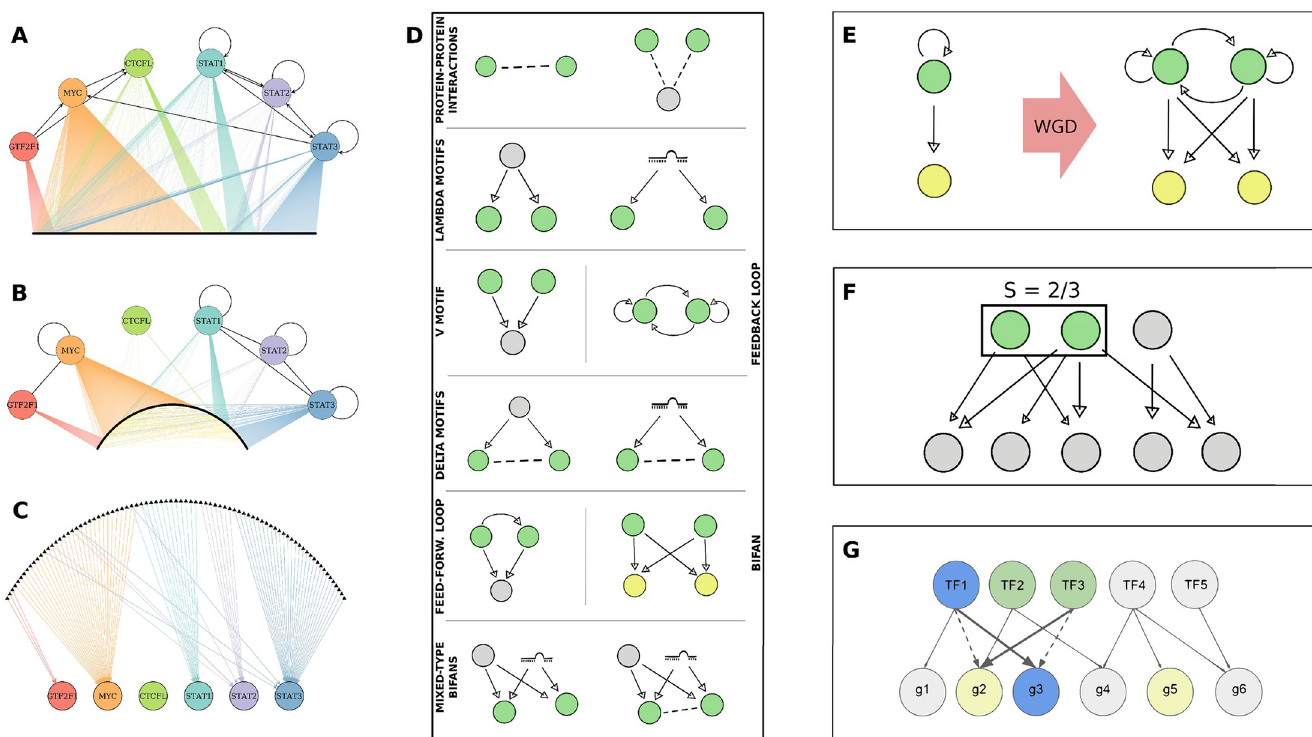
Fig 1. Regulatory networks and network motifs. Interactions involving an illustrative subset of TFs are shown on the left for each of the regulatory mechanisms studied in the present work, i.e. for (A) transcriptional regulations from the ENCODE network, (B) protein-protein interactions in the PrePPI network, and (C) miRNA-gene regulatory interactions in the TarBase network. TFs are represented as colored circles, target genes as small black dots (here appearing as a thick black lines due to large number of genes), and miRNAs as black triangles. Black lines indicate interactions between TFs, while other interactions have the color of the involved TF. Yellow lines are interactions between non-TFs. (D) An overview of the network motifs that will be considered in the following. Gray circles represent generic genes, same-color circles (green or yellow) are paralogues, and miRNAs are represented in a stylized form. Solid arrows represent regulatory interactions, while dashed lines represent protein-protein interactions. (E) Illustration of how a WGD event can easily create FFLs and Bifans by duplicating the components of a simple regulatory interaction in which the regulator also has self-regulation. Many of the created interactions will then be lost during the evolutionary process, leaving only those that are not negatively selected. (F) Example of the structure of a Dense Overlapping Regulon (DOR) embedded in a gene regulatory network, with the target similarity S calculated for an illustrative couple. (G) Graphical representation of the degree-preserving procedure used to generate the null models: the dashed links are randomly chosen and their ends swapped, thus generating the new bold links. Note that all of the involved genes maintain their in and out degree in the